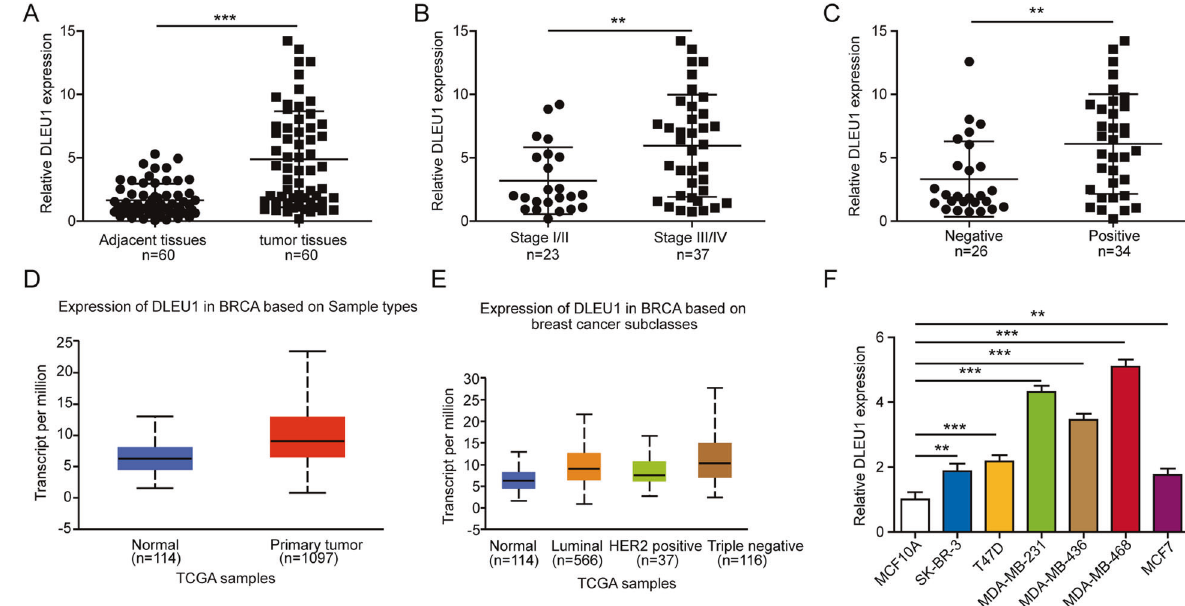
Fig. 1 Higher expression of DLEU1 in breast cancer is an indicator for tumors of higher malignancy. The expression of DLEU in 60 pairs of breast cancer and adjacent normal breast tissues was measured by RT-PCR ( A ), between tumors of different TNM stages ( n = 23 for stage I/II and n = 37 for stage III/IV) ( B ), and between tumors with negative ( n = 26) and those with positive lymph node metastasis ( n = 34) ( C ). DLEU1 expression was analyzed in TCGA database between primary breast tumors ( n = 1097) and normal breast tissues ( n = 114; P < 0.001) ( D ), and between tumors of different molecular subtypes, including 566 luminal, 37 HER2-positive, and 116 TNBC, and normal breast tissues ( n = 114; P < 0.001 between normal and the other three subtypes, and also between TNBC and the other two groups; P > 0.05 between luminal and HER2-positive groups) ( E ). F DLEU1 expression was examined by RT-PCR in non-tumorigenic MCF10A and indicated breast cancer cells. * P < 0.05, ** P < 0.01, *** P <